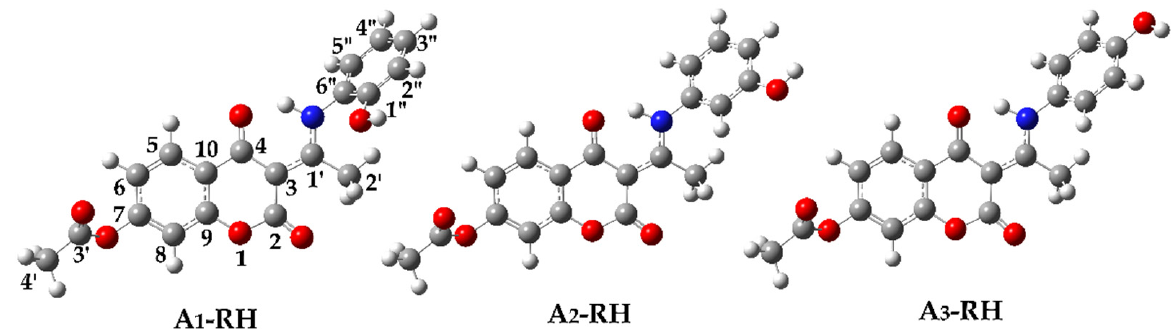
Figure 5. Optimized geometries of investigated compounds in water at M06-2X/6-311++G(d,p) level of theory with carbon atom numbering scheme.